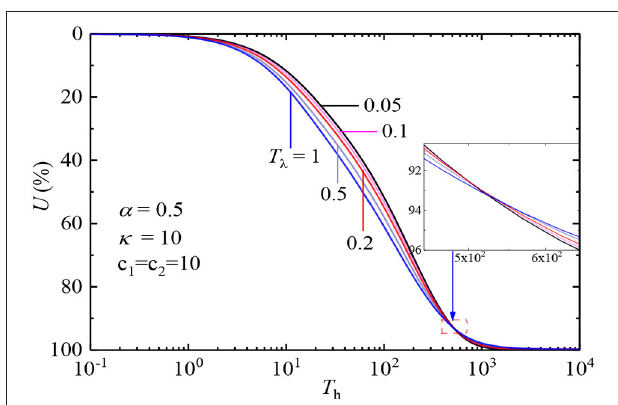
FIGURE 13 | Consolidation process with different values of T λ